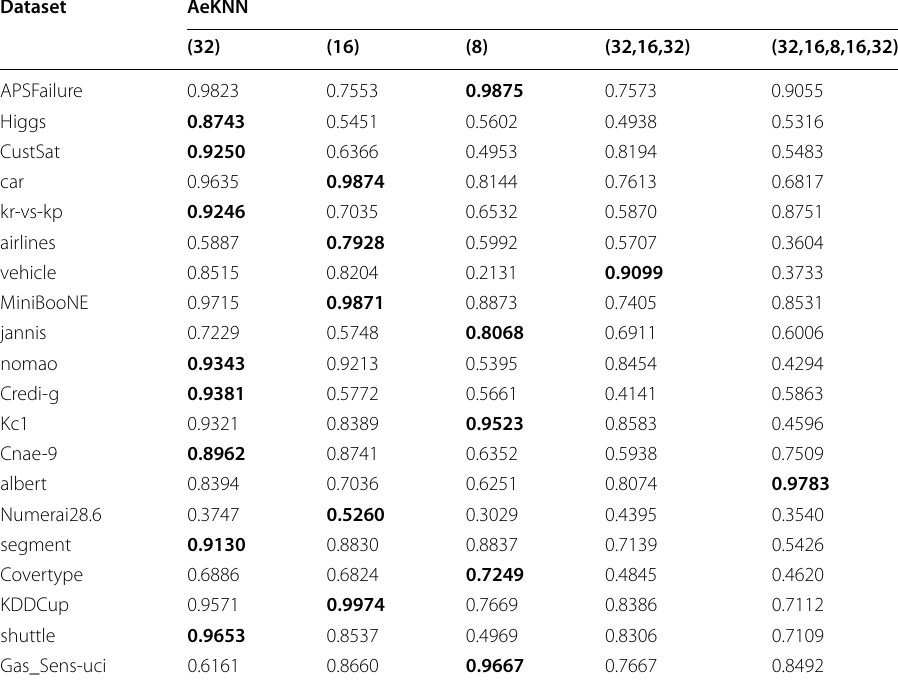
Table 5 F1-Score classification results of the recommended pipelines for the considered AeKNN